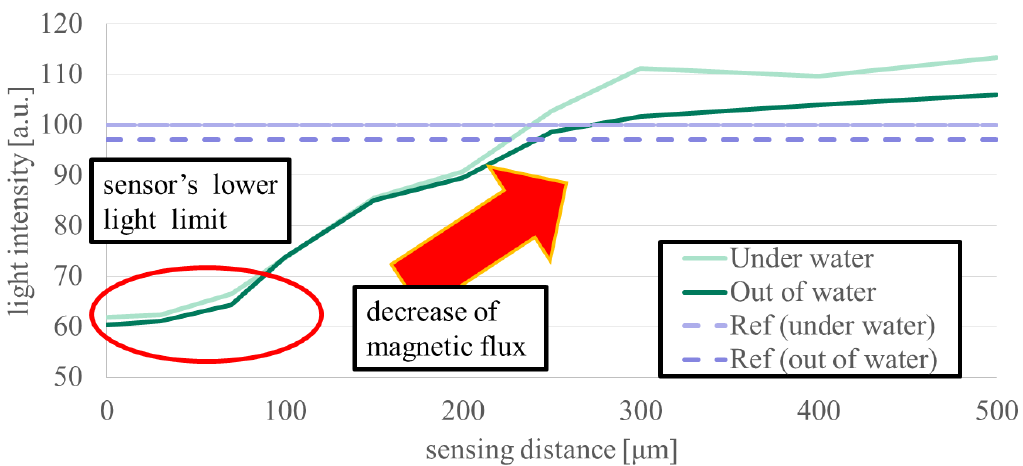
Figure 9. Relation between MO sensing distance and brightness by image analysis software. As the sensing distance D increases, the brightness approaches a constant value, and eventually tag identification becomes difficult. Sensing ability does not significantly differ in air or water. Tag identification is possible in the range of less than 250 μm.